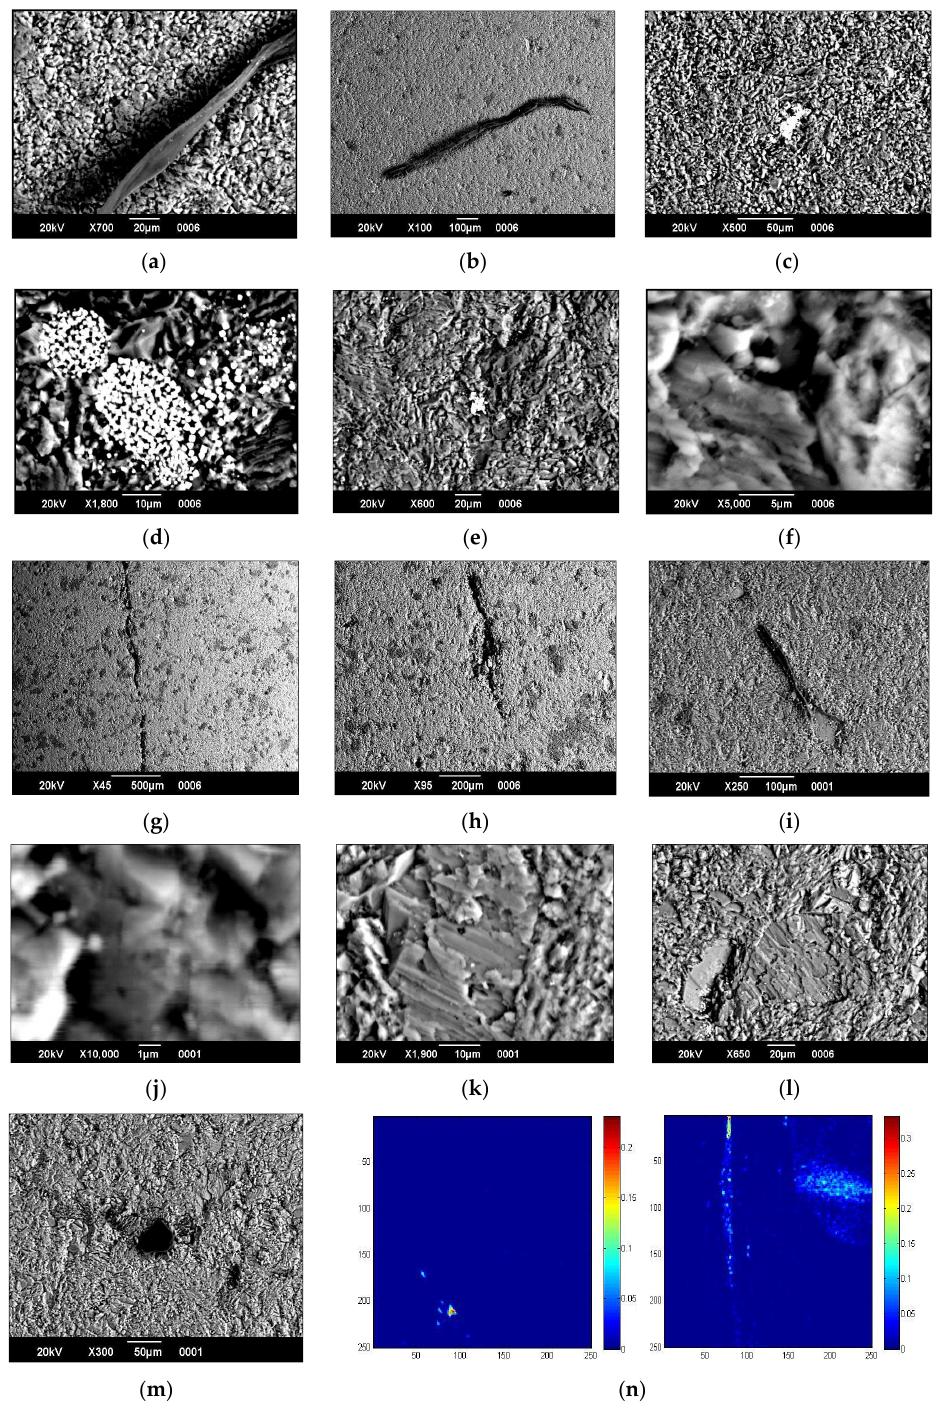
Figure 4. Scanning electron microscopic images of dolomitic limestone samples: ( a ) silicification zone in a “fresh” sample of limestone from a borehole; ( b ) the same, structural details; ( c ) baritisation zone (white in the centre) in a limestone sample from a borehole; ( d ) pyritisation zone (light) in a limestone sample from a borehole; ( e ) fractured intermittent areas with disrupted rock continuity in a weathered limestone sample; ( f ) the same, structural details; ( g , h ) microfracturing with individual bulges in the samples of weathered limestone; ( i , j ) the development of micropores 1–2 microns in size in the calcite of weathered limestones; ( k ) the “pitted” form of calcite grains in weathered limestone resulting from their leaching; ( l ) the deformation of recrystallisation and metasomatic zones in a weathered limestone sample; ( m ) carbonaceous matter (black), confined to pores and cavities in weathered samples; ( n ) fracture maps of “fresh” ( left ) and “weathered” ( right ) limestone sample. Table 3. Results of crack measurement and calculation in dolomitic limestone samples according to 3D X-ray tomography. Crack Size, μ m Borehole Core Samples Outcrop Surface Samples Number of Proportion of Cracks of a Number of Proportion of Cracks of a